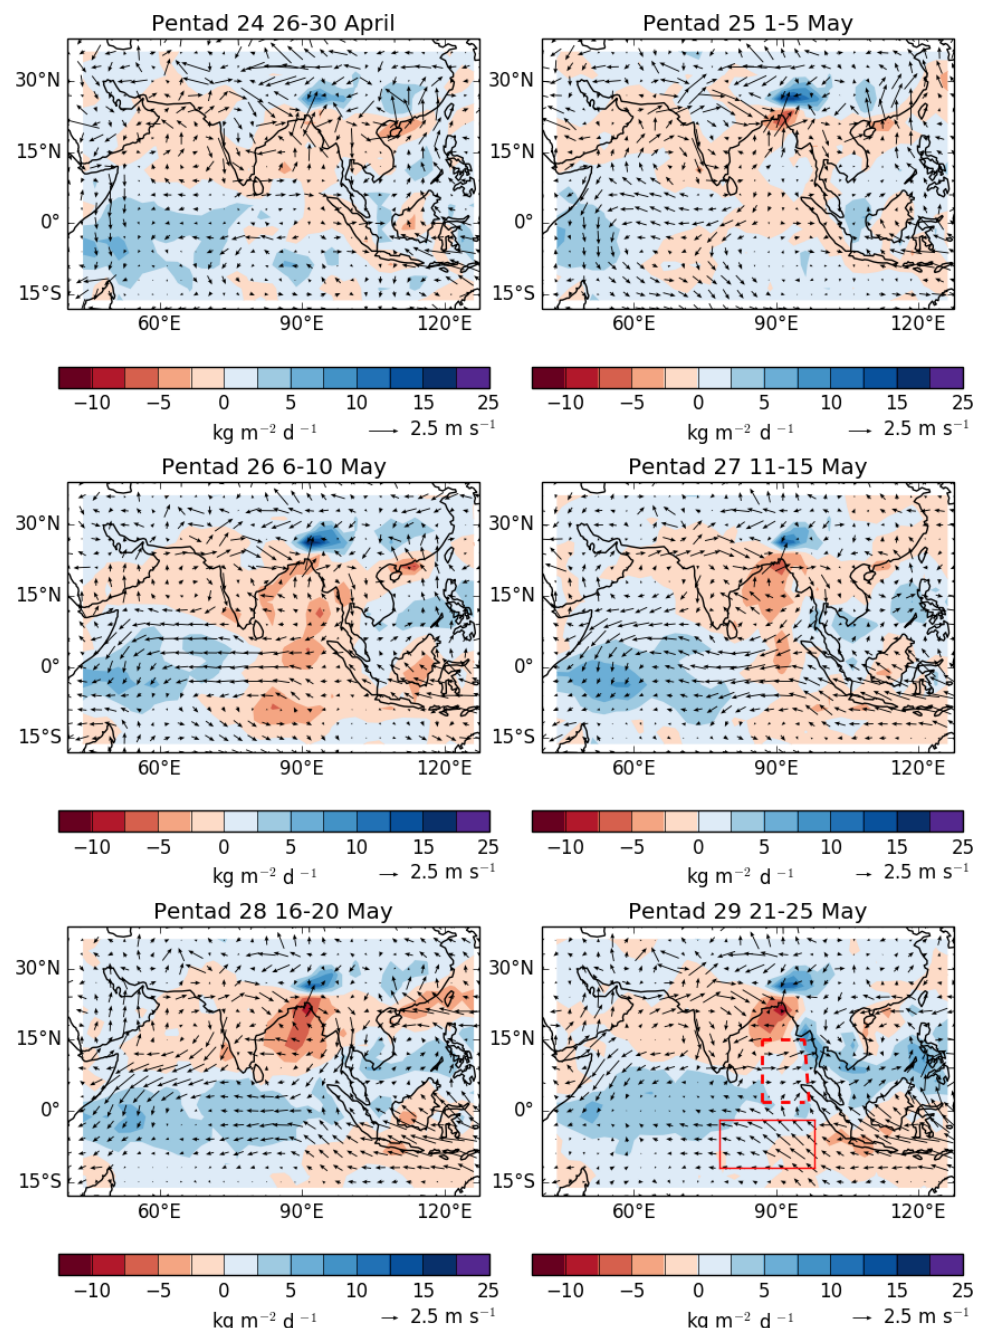
Figure 10. Development of climatological errors in 850hPa winds and precipitation (against ERA-I and GPCPv2), pentad by pentad after initialisation on 25 April. The red boxes indicate the northern (dashed) and southern (solid) EEIO boxes used in Fig. 8e,